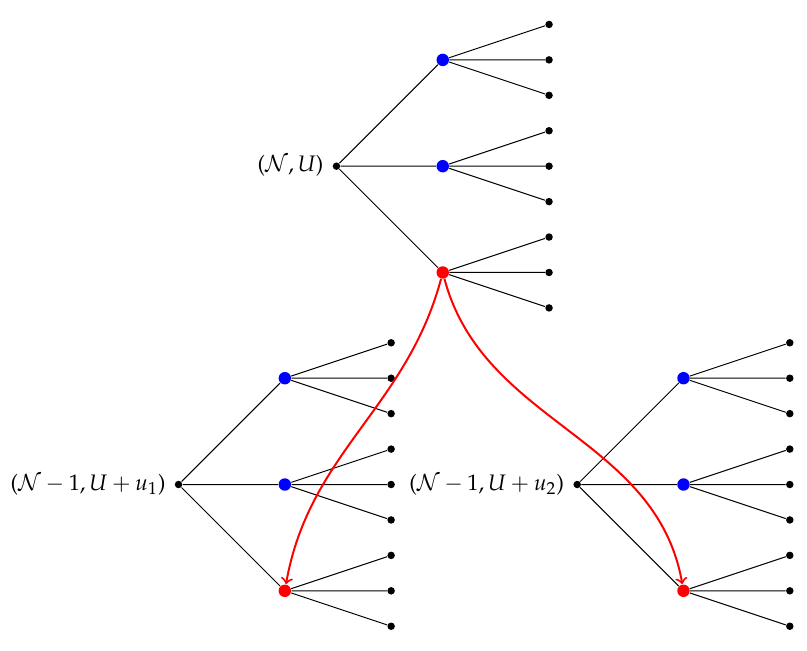
Figure 1. Section of a Forest of Trees with N = # of exercise rights remaining, U = usage level, and three exercise choices—no exercise, excerise u 1 units, and exercise u 2